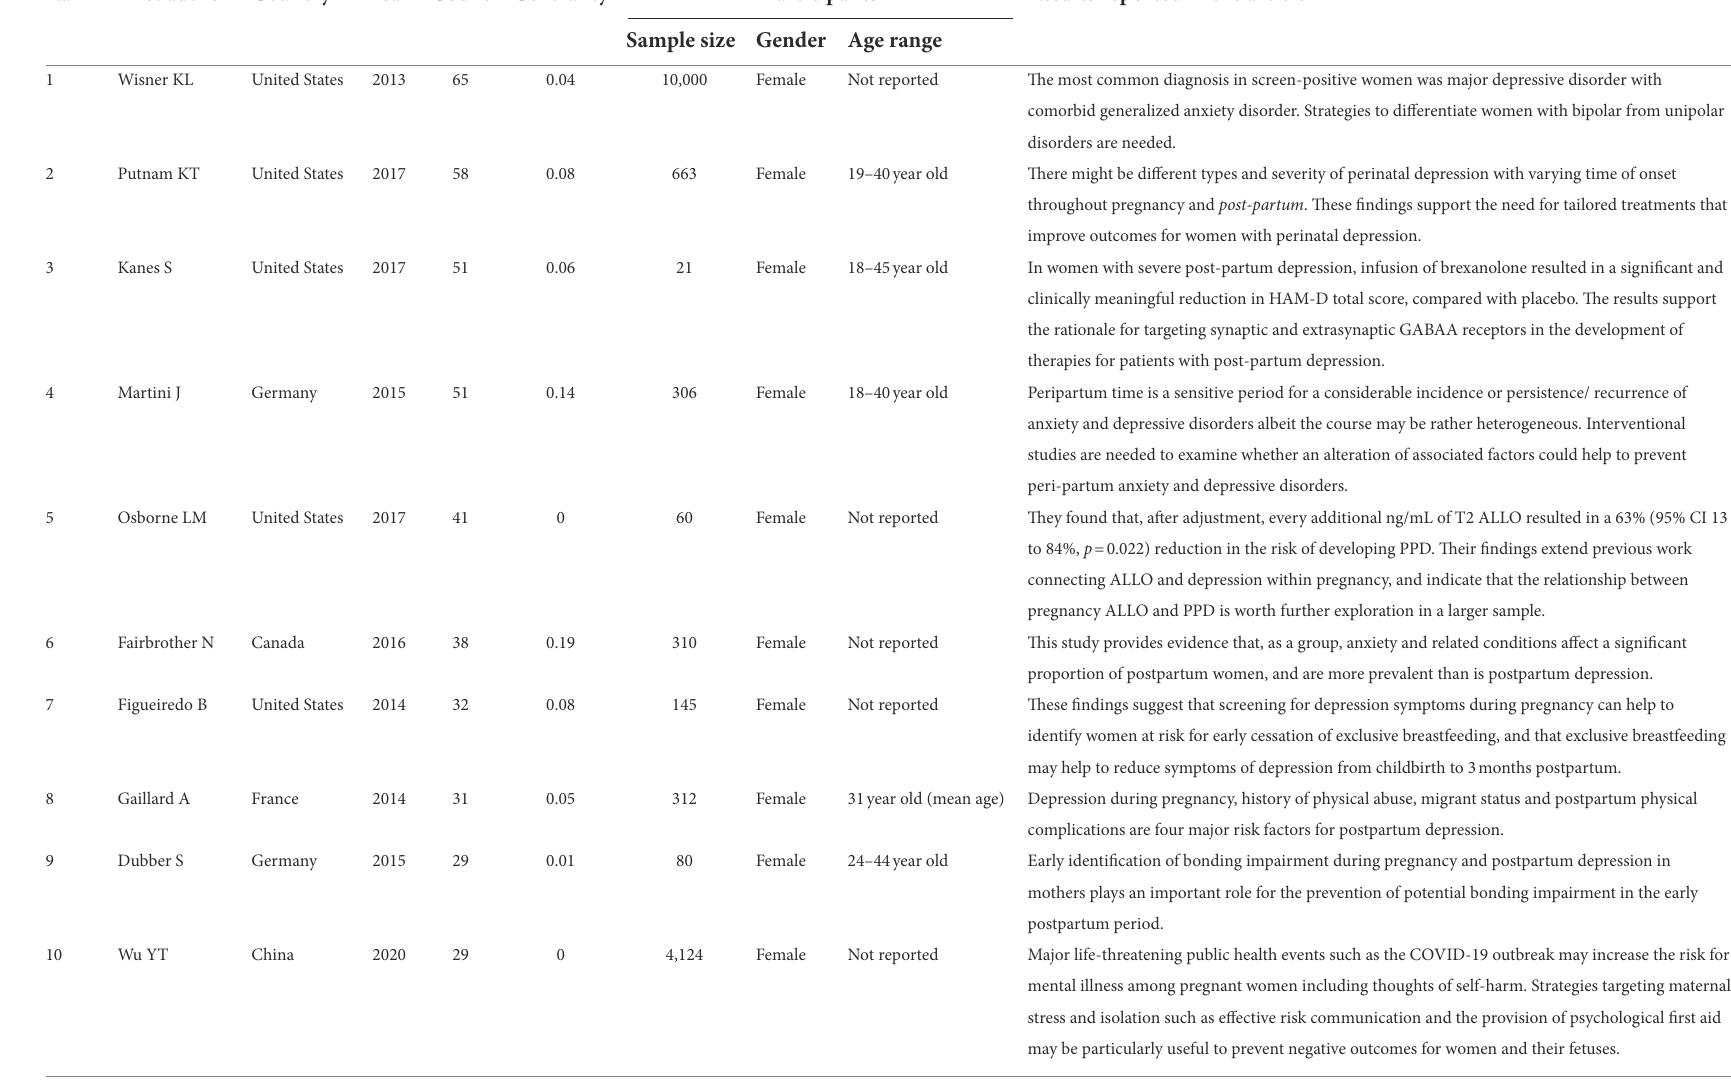
TABLE 5 Top 10 original research articles cited frequently in PPD